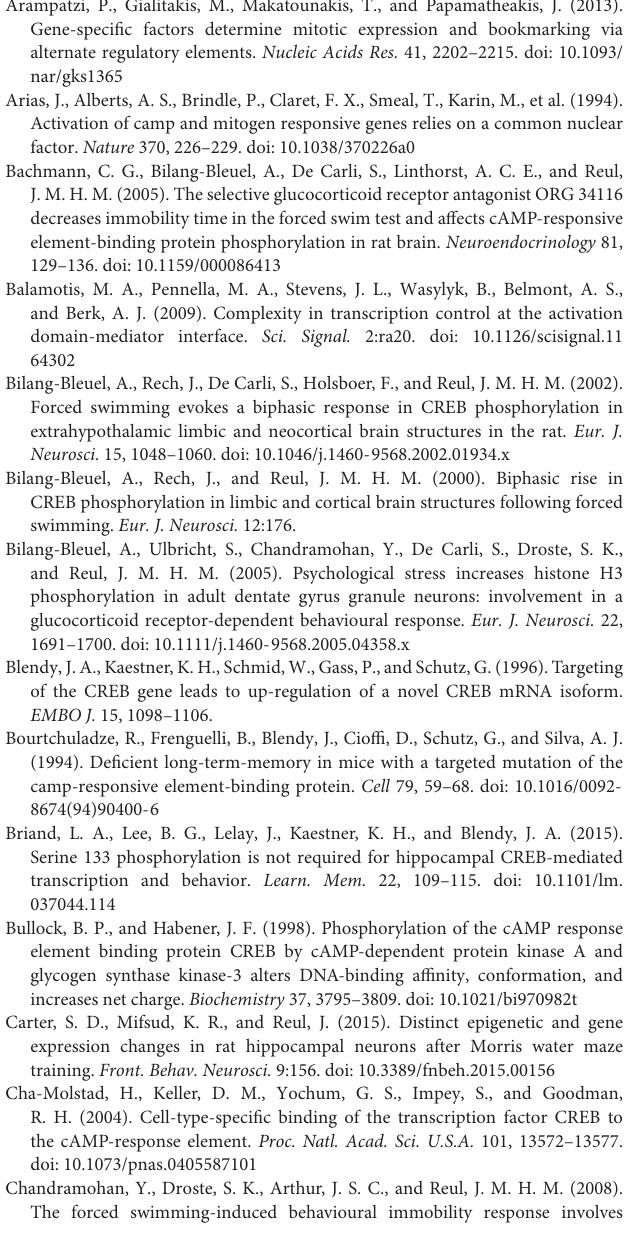
FIGURE S3 | pCREB binding to the CREs in the promoter regions of c-Fos and Egr-1 . Rats were killed either under baseline conditions or 5 or 15 min after the start of FS (25 ◦ C water). Chromatin immuno-precipitation was carried out on whole hippocampal tissue using antibodies against pCREB. Primers for qPCR were designed to cover the CREs in the promoter regions of c-Fos and Egr-1 ( Table 2 ). The graphs show the enrichment of (A) pCREB at the c-Fos promoter CRE, and (B) pCREB at the Egr-1 promoter CRE/SRE. The enrichment for each group was calculated by dividing the quantity of target DNA in the bound fraction by the quantity of DNA in the input fraction (ratio bound over input, B/I), as determined by qPCR analyses (see section “Materials and Methods”) [mean ± SEM, n = 4]. Statistical analysis: One-way ANOVA; (A) F ( 2 , 9 ) = 0.1388, p = 0.8722, (B) F ( 2 , 9 ) = 0.7502, p = 0.4996.